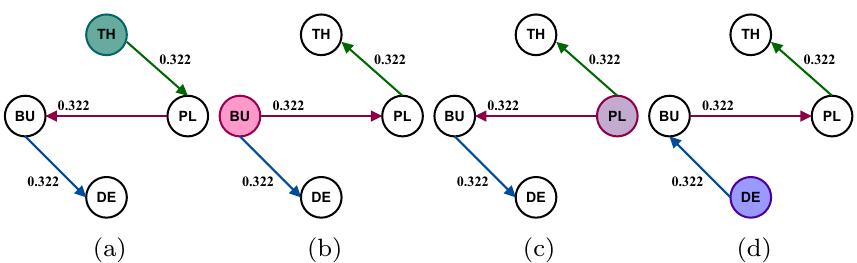
− 5.033(b) Choose BU as root node = − 5.6925 (d) Choose De as root node and its LL =